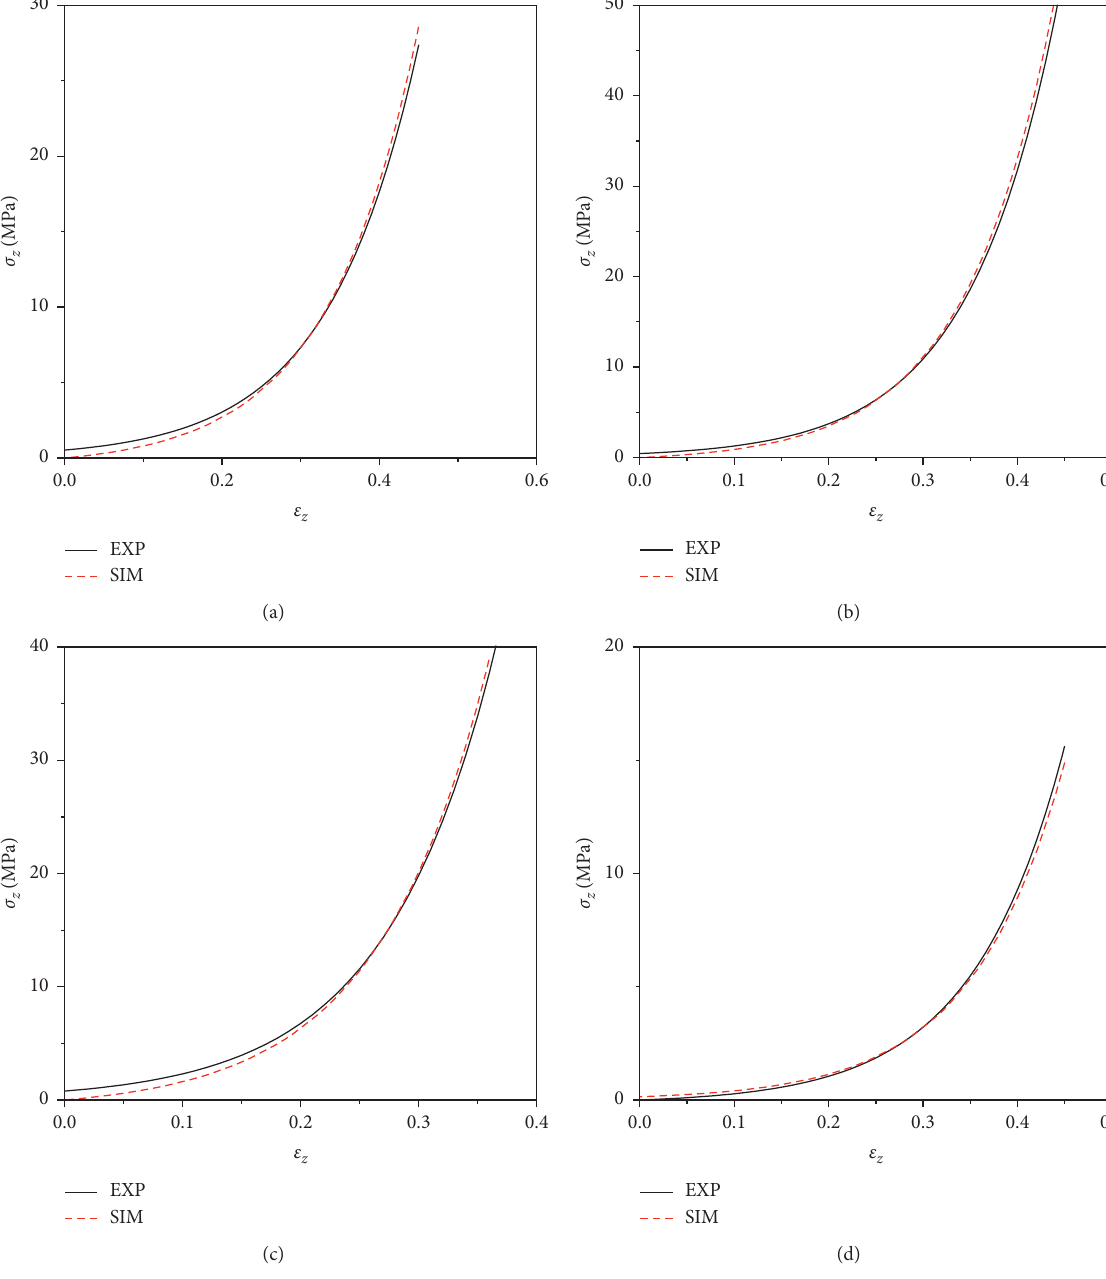
Figure 5: Comparison of stress-strain curves of various broken rocks in experiment and simulation. (a), (b), (c), and (d) represent broken rock